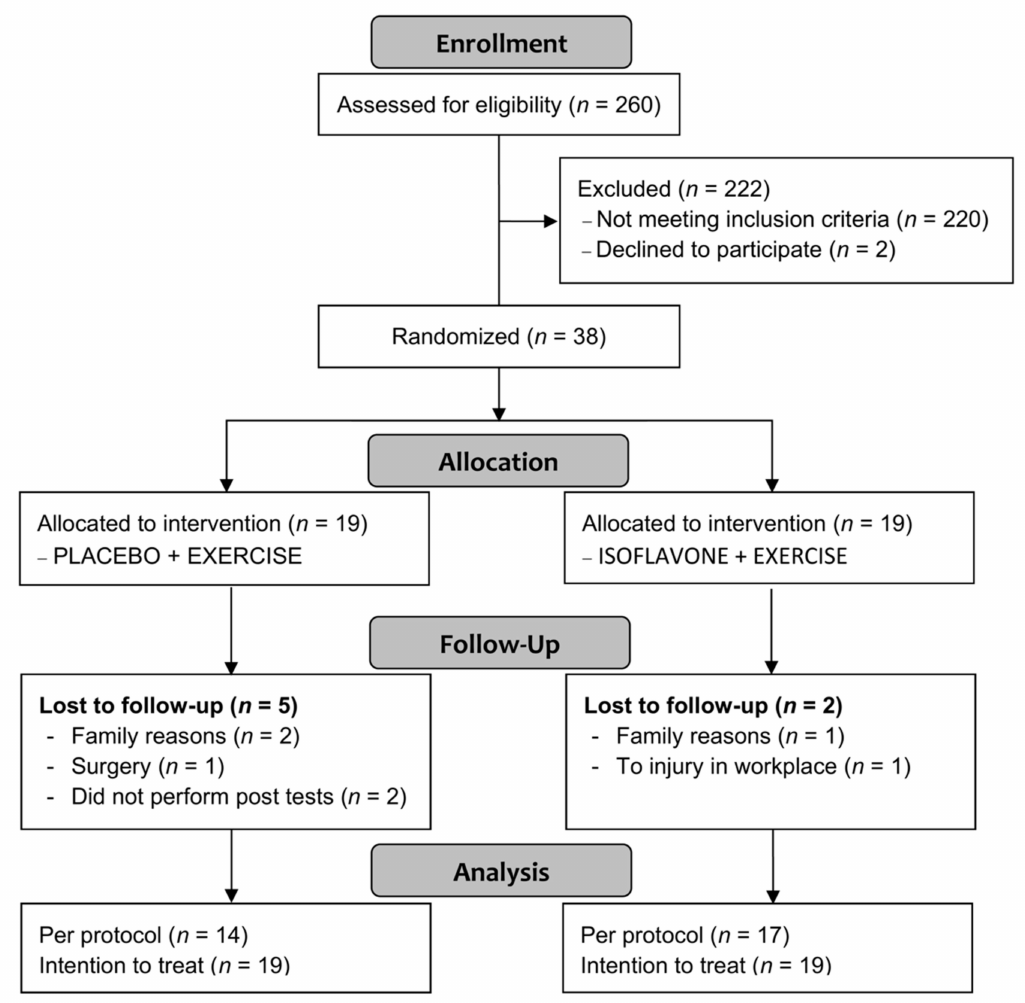
Figure 1. Flowchart of study participants.